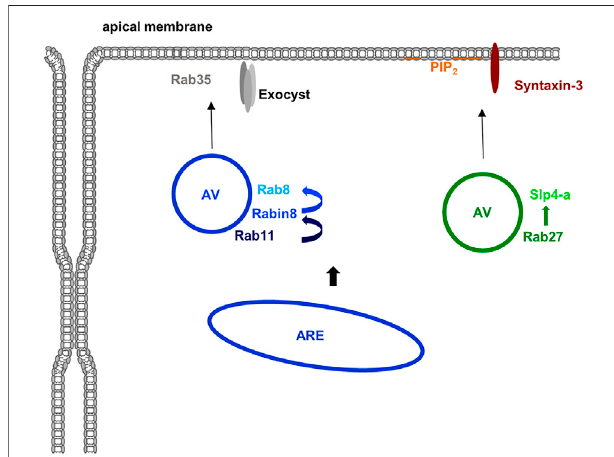
FIGURE 6 | Rab proteins in apical membrane traf fi c. Several Rab proteins are known to participate in the delivery of material to the apical membrane domain in polarized epithelial cells. Apically destined vesicles (AV) contain Rab11 which recruits the Rab8 GEF Rabin8 thereby activating Rab8. Rab35 and the exocyst complex are most likely involved in the apical membrane targeting of these vesicles. Another class of apically destined vesicles operating in the formation of an apical lumen in 3D are positive for Rab27 (and most likely also Rab3 isoforms). The Rab27 effector Slp4-a is targeted to these vesicles and most likely functions in conjunction with Slp2-a to tether the vesicles at PtdIns(4,5)P 2 -rich apical membrane domains with fusion eventually mediated by syntaxin-3. Most likely, both types of vesicles originate at the apical recycling endosome (ARE) although formation at the TGN is also feasible at least for the Rab27 positive